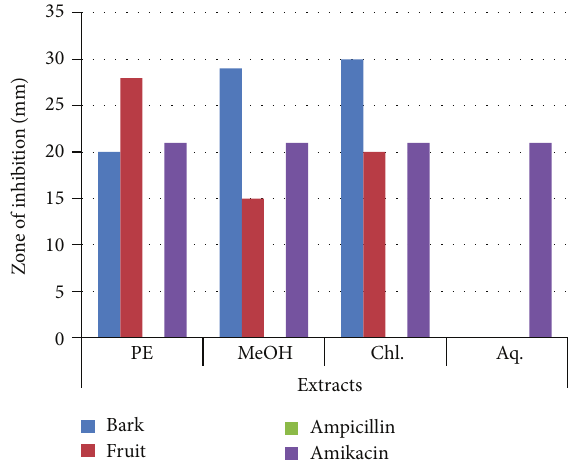
Figure 5: Zone of inhibition produced by different parts of C. ambrosioides against P. aeruginosa .